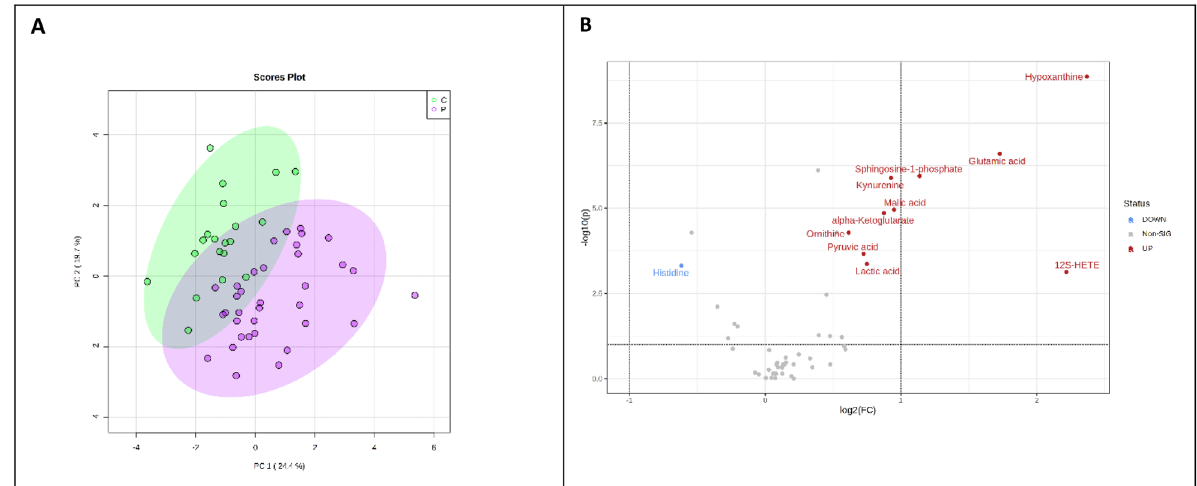
Figure 1. Plasma metabolite concentrations differ between healthy controls and PH patients. ( A ) Principal component analysis was performed between patients and controls. ( B ) A Vulcano plot identifies metabolites that differ among the patients compared to the healthy controls with a 1.5 fold-change and FDR corrected. The direction of comparison was patients/controls.